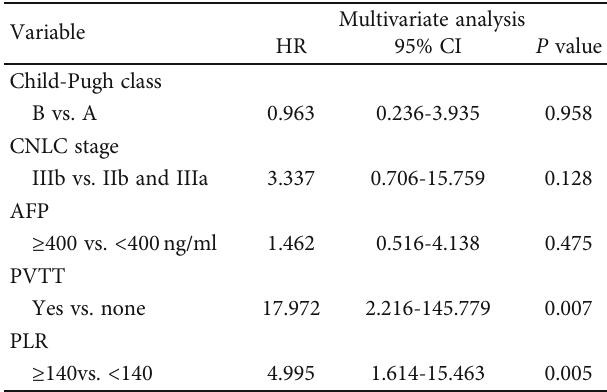
Table 4: Multivariate Cox proportional hazards regression models for progression-free